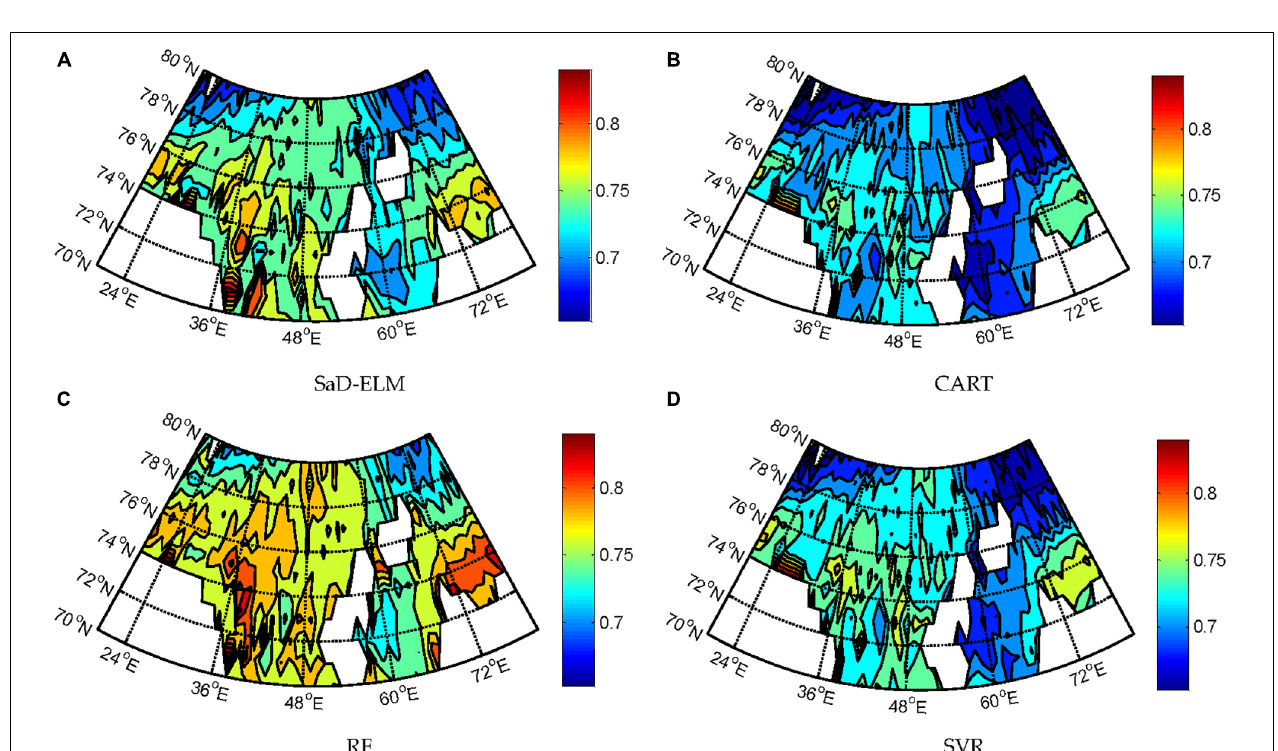
FIGURE 9 | R of predicted SIC at each grid point of B-K sea with four models (lead time = 1 day). (A) SaD-ELM. (B) CART. (C) RF. (D) SVR.